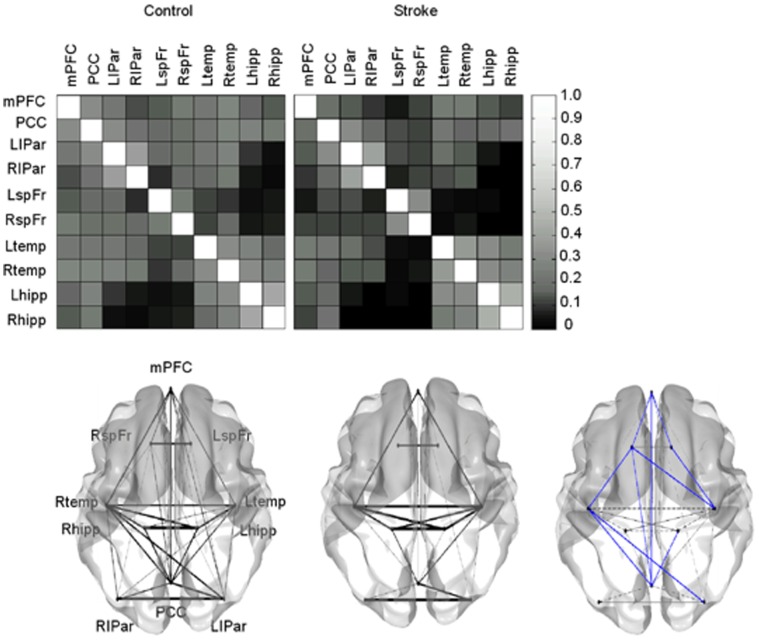
Region of interest (ROI) based analysis for the control and stroke subjects.The top panel displays the correlation coefficients matrices for every pair-wise region. The bottom panel displays the graph visualization of the correlation coefficient matrices thresholded at r>0.15. The bottom right represents the significant differences between control and stroke subjects; blue lines depicting stronger correlations in control with respect to stroke subjects at the threshold P<0.05, overlaid on the graph visualization of the stroke patients. In the opposite contrast, no stronger functional correlations were found in stroke subjects. mPFC = medial prefrontal cortex, PCC = posterior cingulate cortex, LIPar = left inferior parietal cortex, RIPar = right inferior parietal cortex, LspFr = left superior frontal cortex, RspFr = right superior frontal cortex, Ltemp = left middle temporal cortex, Rtemp = right middle temporal gyrus, LMTL = left medial temporal lobe, RMTL = right medial temporal lobe.